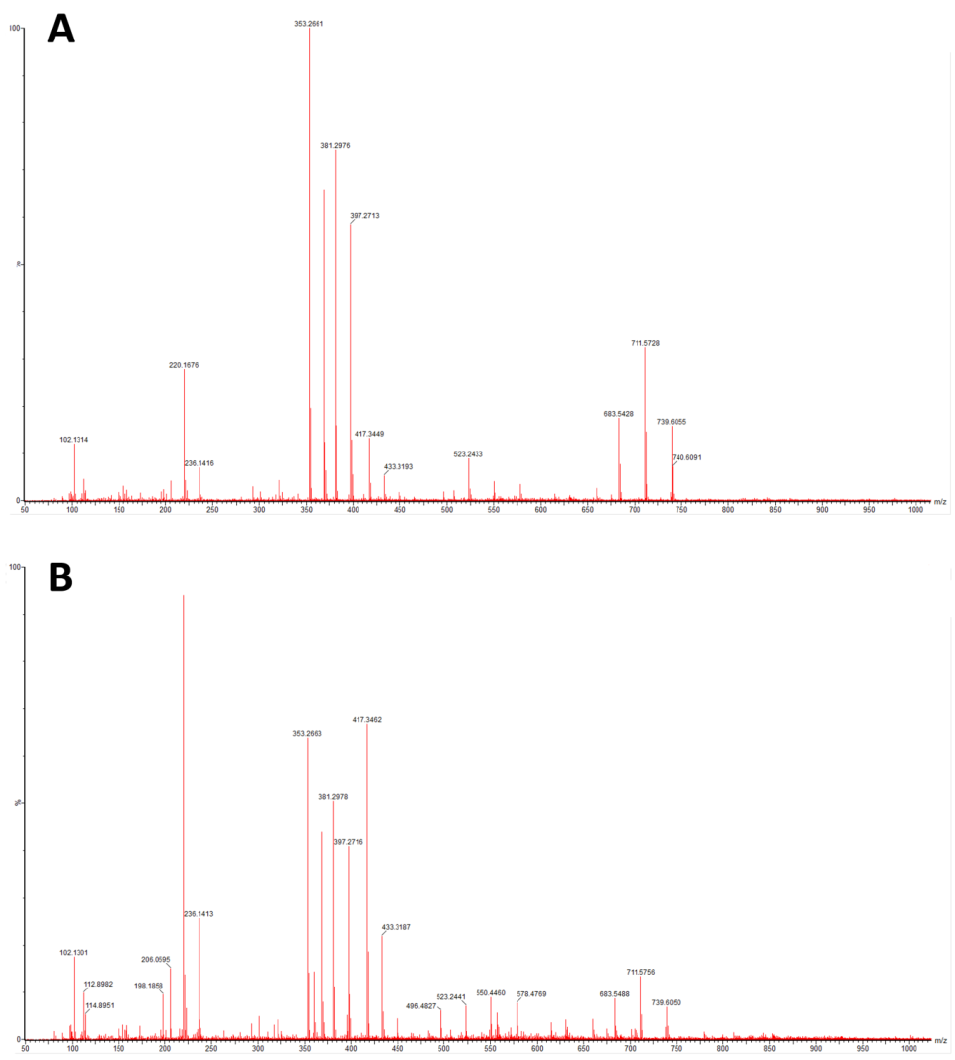
Figure 11. MS spectra for ( A ) PA12_CS_NS and ( B ) PA12_CS_S samples.